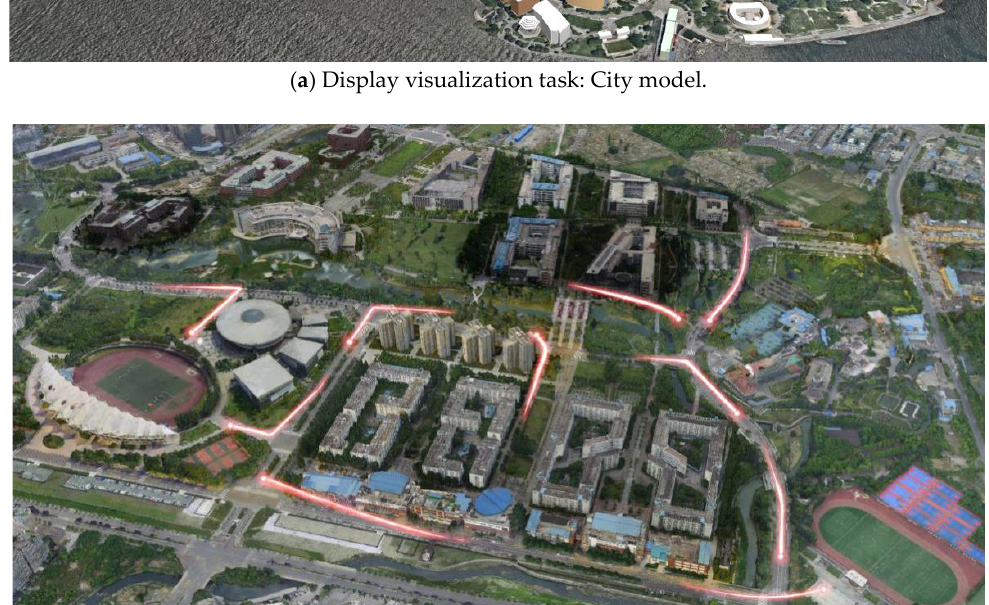
( b ) Analytical visualization task: Escape route of earthquake disaster.